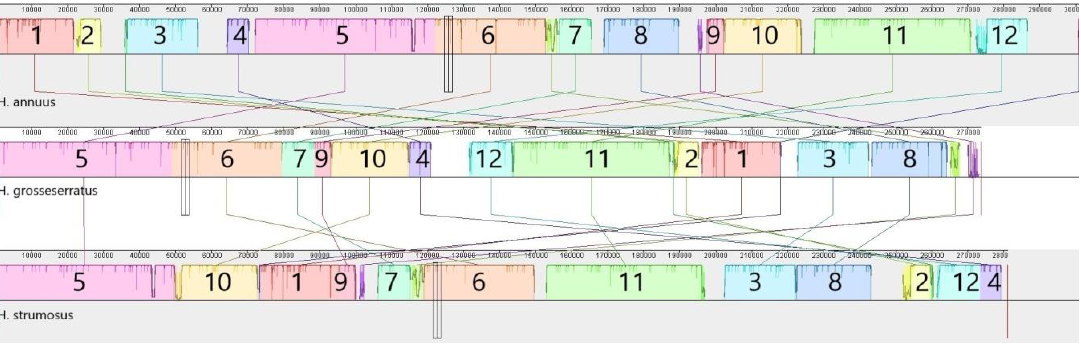
Figure 2. The progressive MAUVE alignment of H. annuus , H. grosseserratus and H. strumosus complete mitogenomes. According to sequence similarity, 12 syntenic blocks were identified, with a different order for each species.